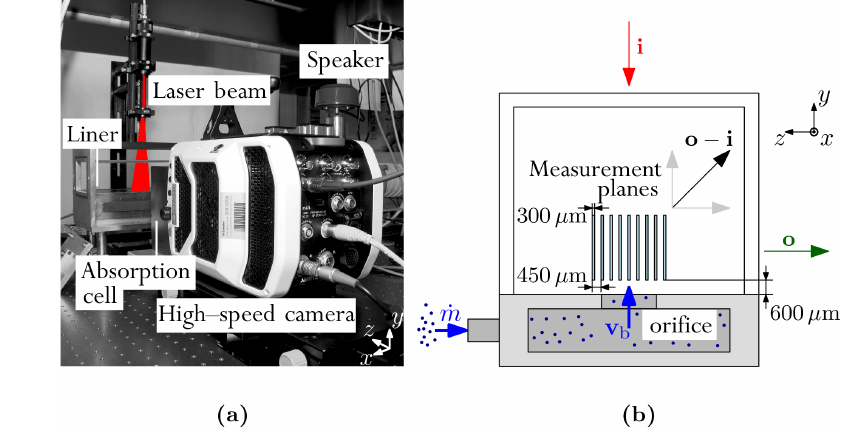
Figure 5. Measurement setup: (a) the test rig is acoustically excited by a speaker, and the sound–flow interaction at the liner is measured using the FM-DGV system in combination with a high-speed camera. The suction unit for generating the grazing flow v g is installed behind the speaker. (b) The laser light sheet and the imaging system are traversed in z direction in steps of 450µm. In the nine resulting measurement planes, the velocity component v in the direction of the vector ( o − i ) is measured. Note that the sketch is not drawn to scale in order to gain a better